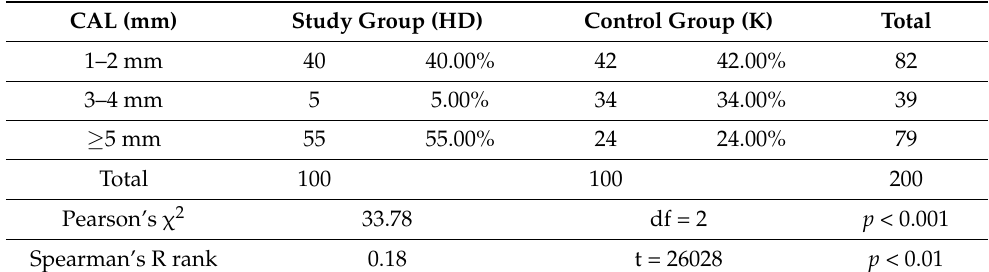
Table 4. Comparison of the distribution of clinical values of the level of connective tissue attachment (CAL) in both study groups (HD,